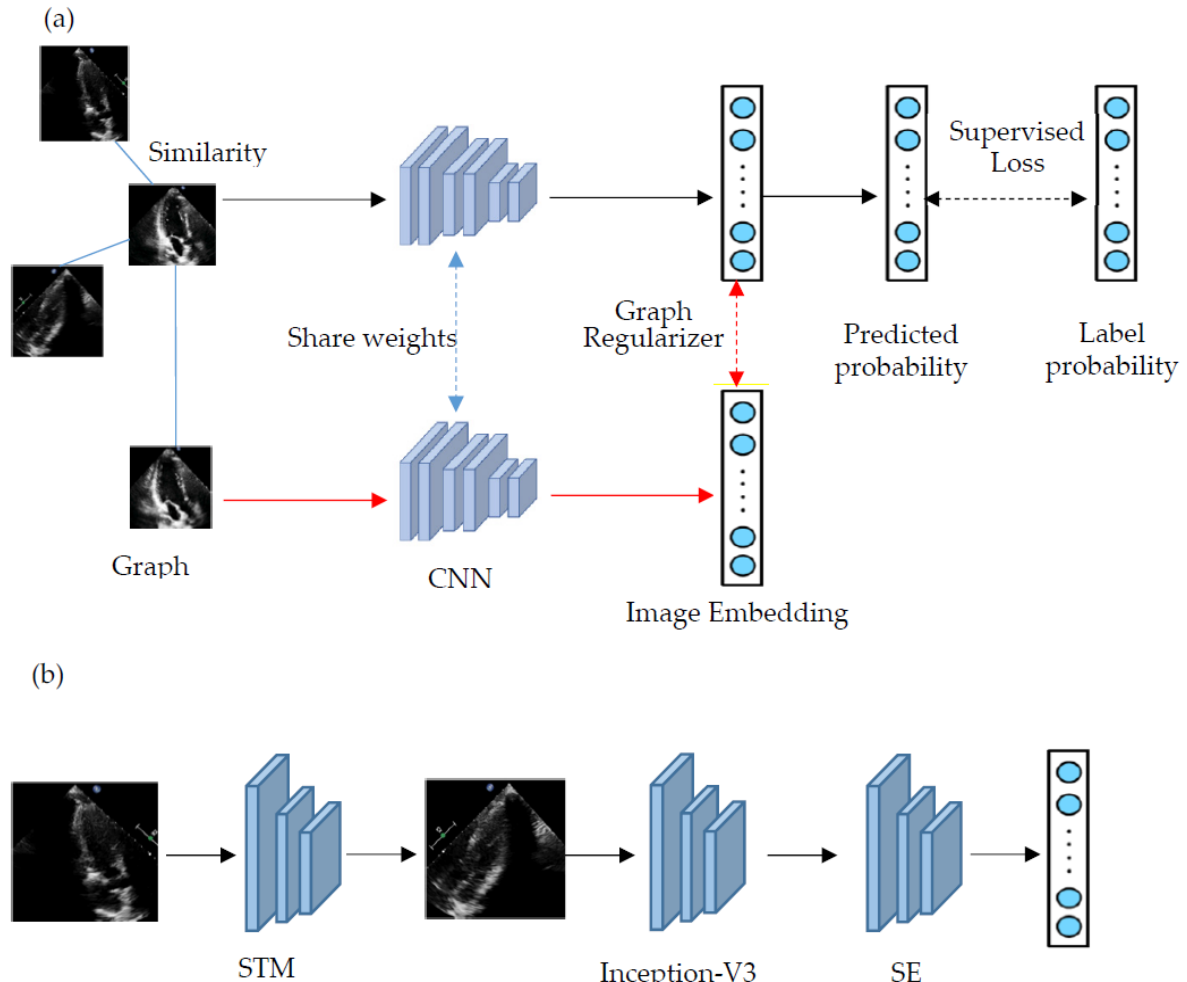
Figure 1. An illustration of the proposed classification framework. ( a ) The sample with similar samples defined by the similar graph are inputted into the same CNN, and the representation produced by similar samples is used as graph regularizer to compute unsupervised loss, which are combined with supervised loss to train the CNN. ( b ) The CNN includes three modules. STM learns the six affine parameters of the cardiac deformations to reduce the geometric distortion. The Inception-V3 with output layer removed is used for feature extraction. The extracted feature maps are inputted to the SE, which adaptively recalibrates channel-wise feature responses, and then the predicted probability is outputted.